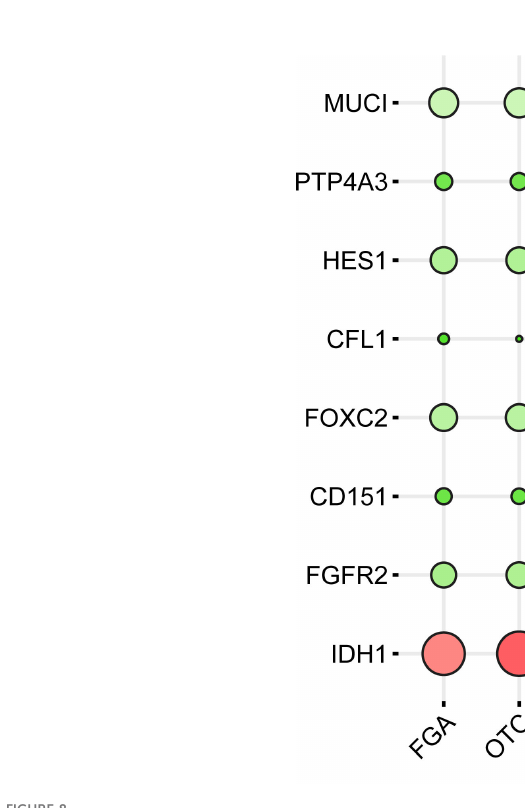
FIGURE 8 Heatmap of the correlation of (FGA, OTC, CTH, and MMP11) with clinical CCA stage-speci fi c and/or metastatic